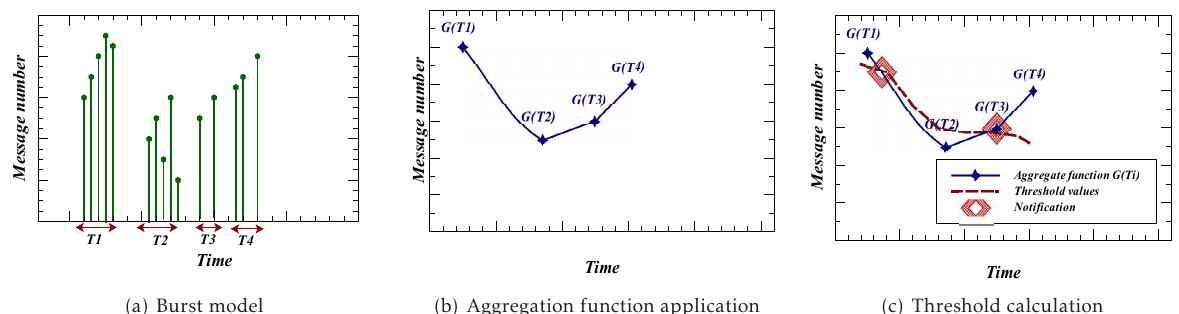
Figure 6. Threshold calculation for the burst